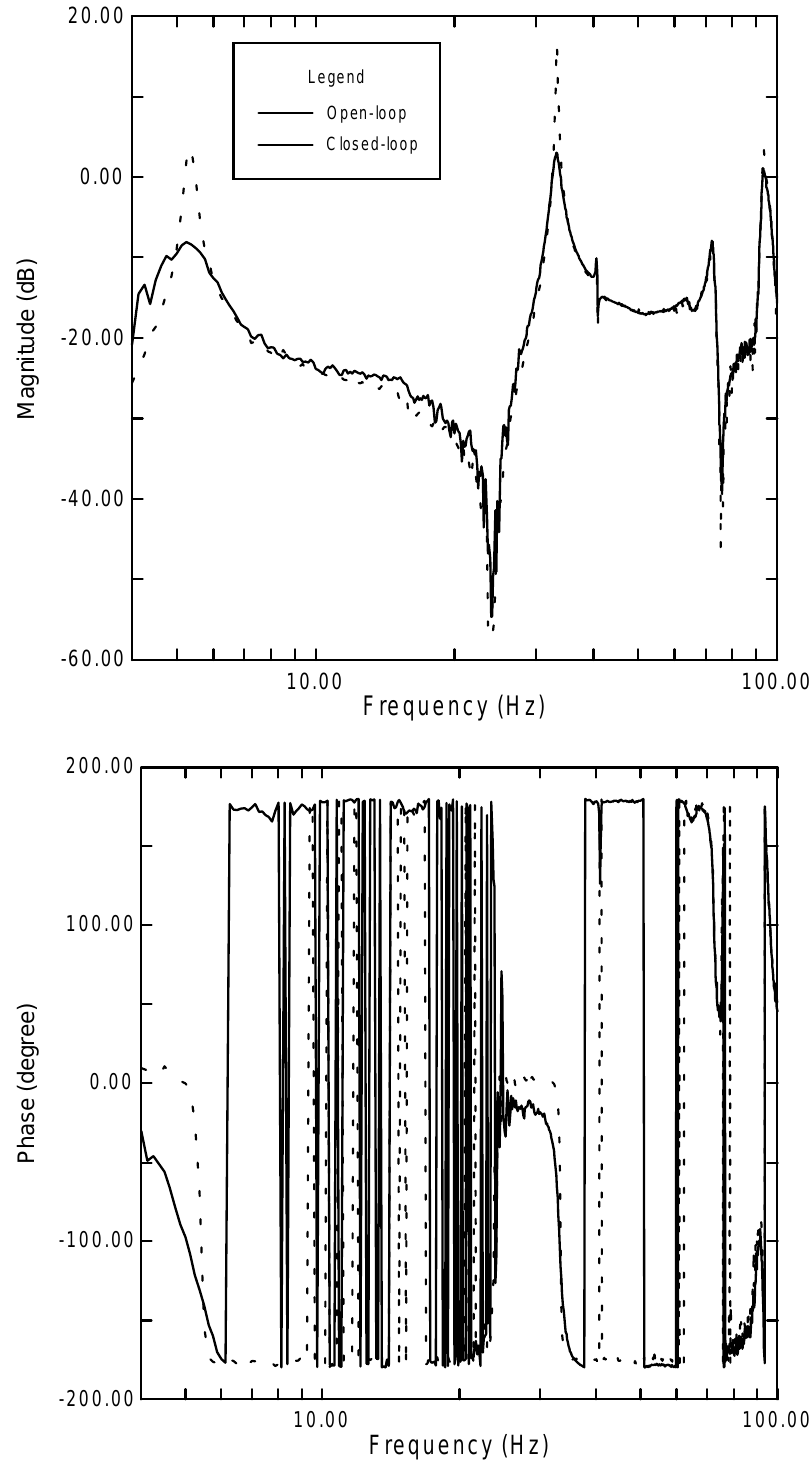
Fig. 16. Open and closed-loop transfer functions of the